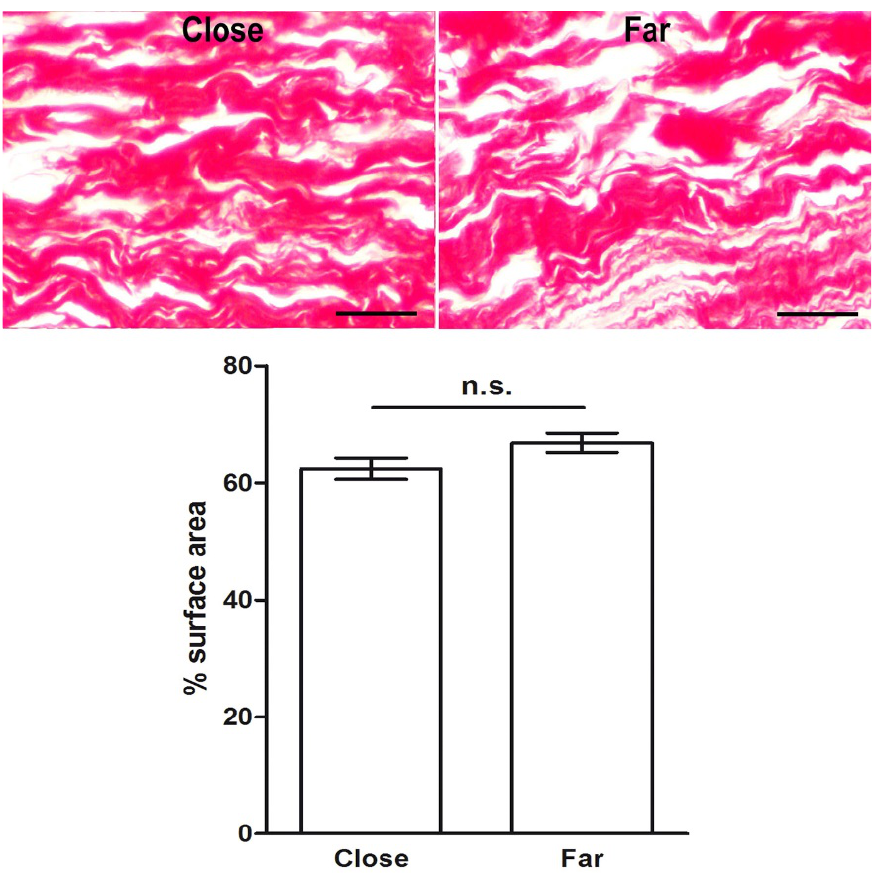
Figure 6. Light microscopic appearance and morphometry of collagen fibers from vein areas of the tunica adventitia located close to and far away (3–5 mm) the surgical wound. No substantial differences can be seen or measured. PSR staining; bars = 100 µ m; values are mean ± s.e.m., n = 4, n.s. not